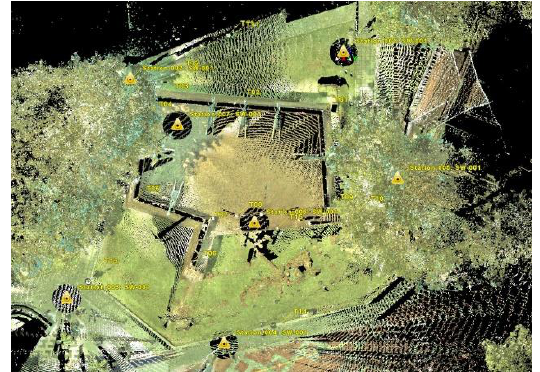
Figure 1. Planning for laser scanning survey – the location of scanning stations and sphere targets